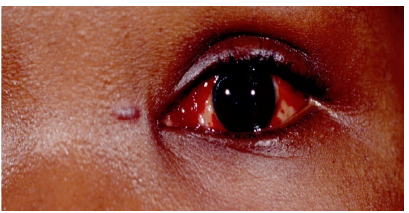
Figure 2. Kaposi sarcoma on the bulbar conjunctiva (Photo Courtesy of Dr Linda Visser)